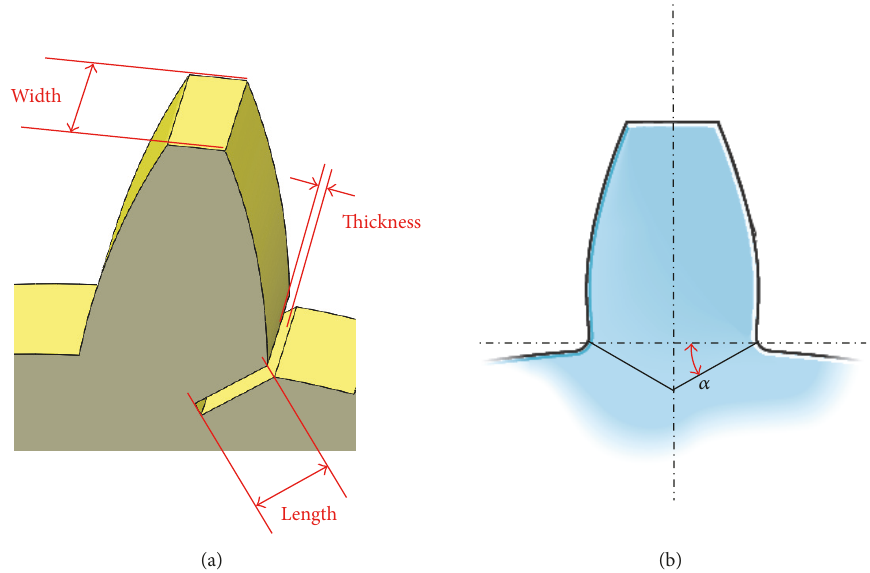
Figure 1: Schematic representation of a crack. (a) A 3D view and (b) a 2D